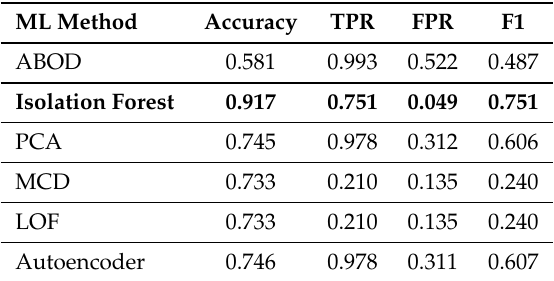
Table 3. Evaluation Results of the Second ARIES Detection Layer